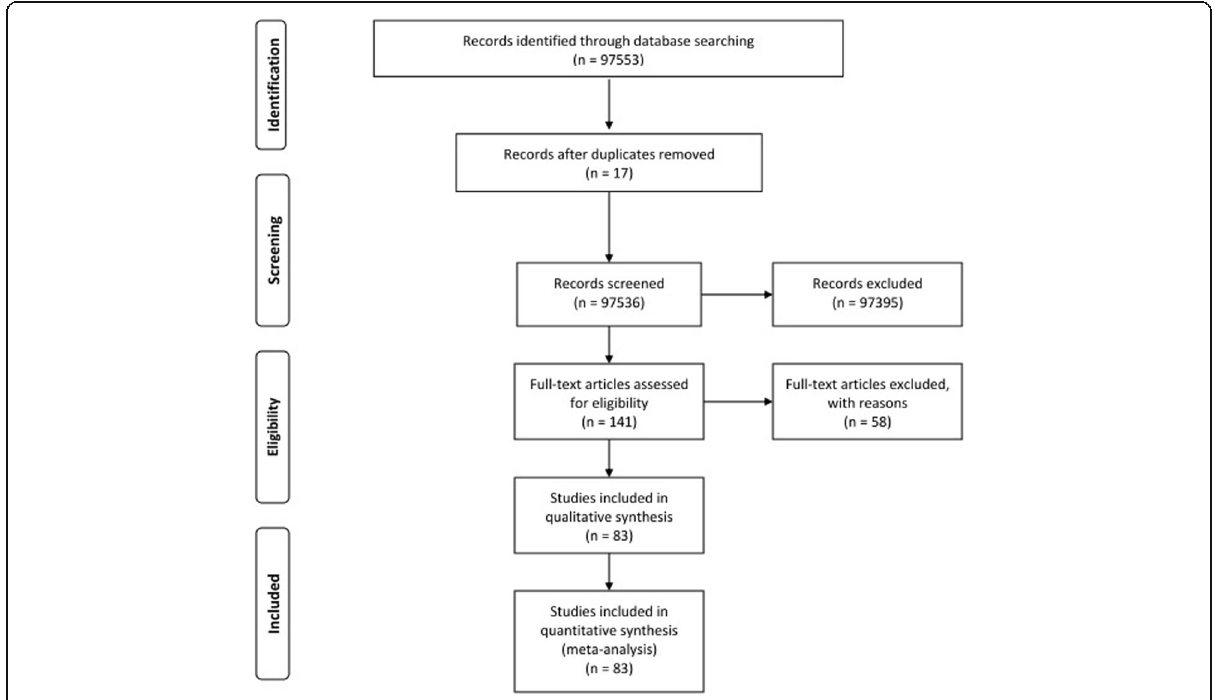
Fig. 1 Flow diagram of the study design